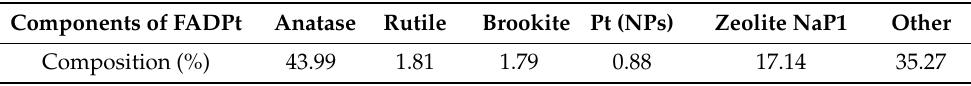
Table 2. Surface characteristics of FA and